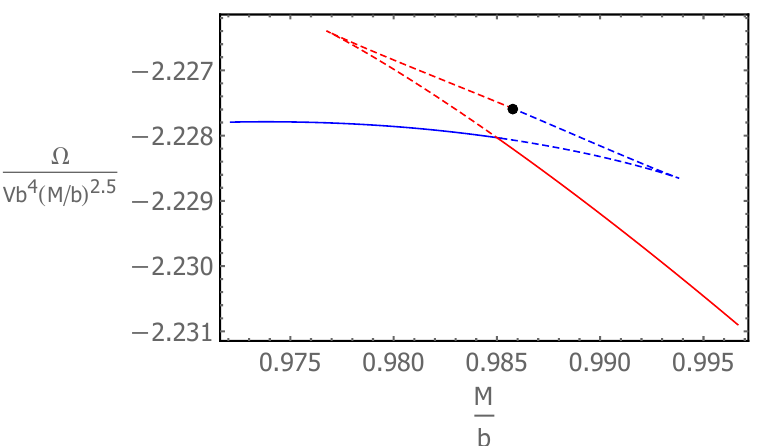
Figure 2 . The free energy density as a function of M=b for q 0 = 15. The blue (dashed) lines are solutions generated from the Weyl semimetal phase while the red (dashed) line are from the insulator phase. The black dot represents the free energy at the unstable critical point. The system undergoes a (cid:12)rst order quantum phase transition from the Weyl semimetal phase to an insulating